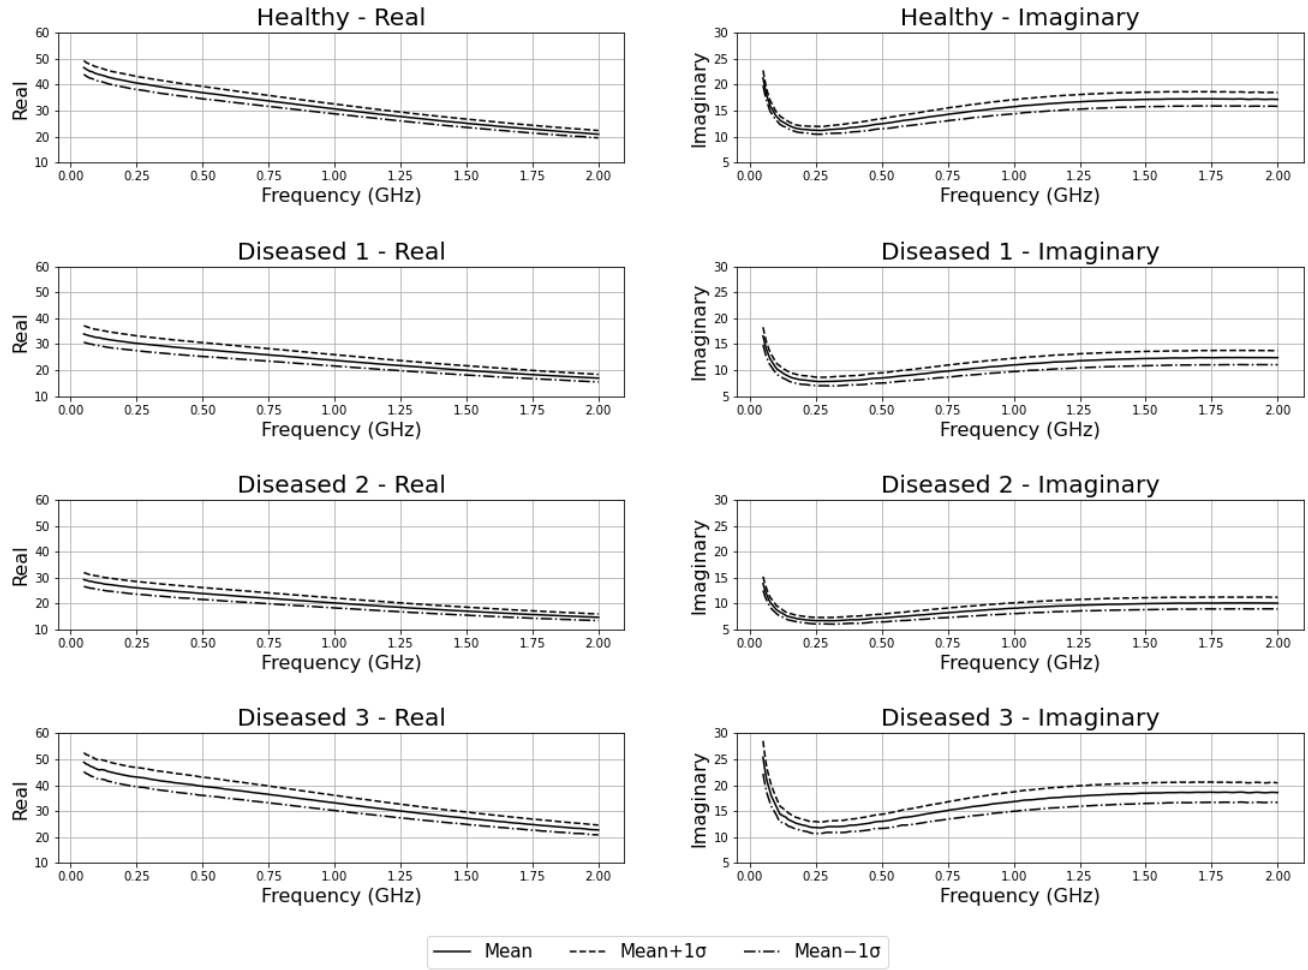
Figure 3. Measured complex permittivity for all tissue types individually.